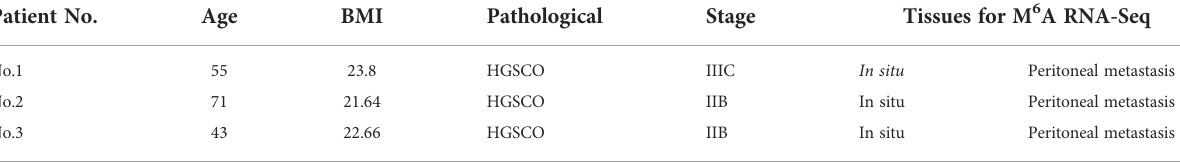
HGSCO, High grade serious carcinoma of